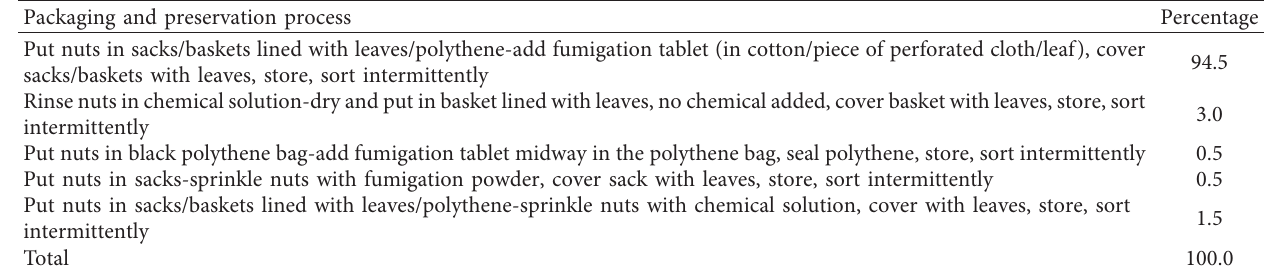
Table 11: Processes of packaging and preservation of the kola nuts for storage by the respondents ( N � 199). Packaging and preservation process